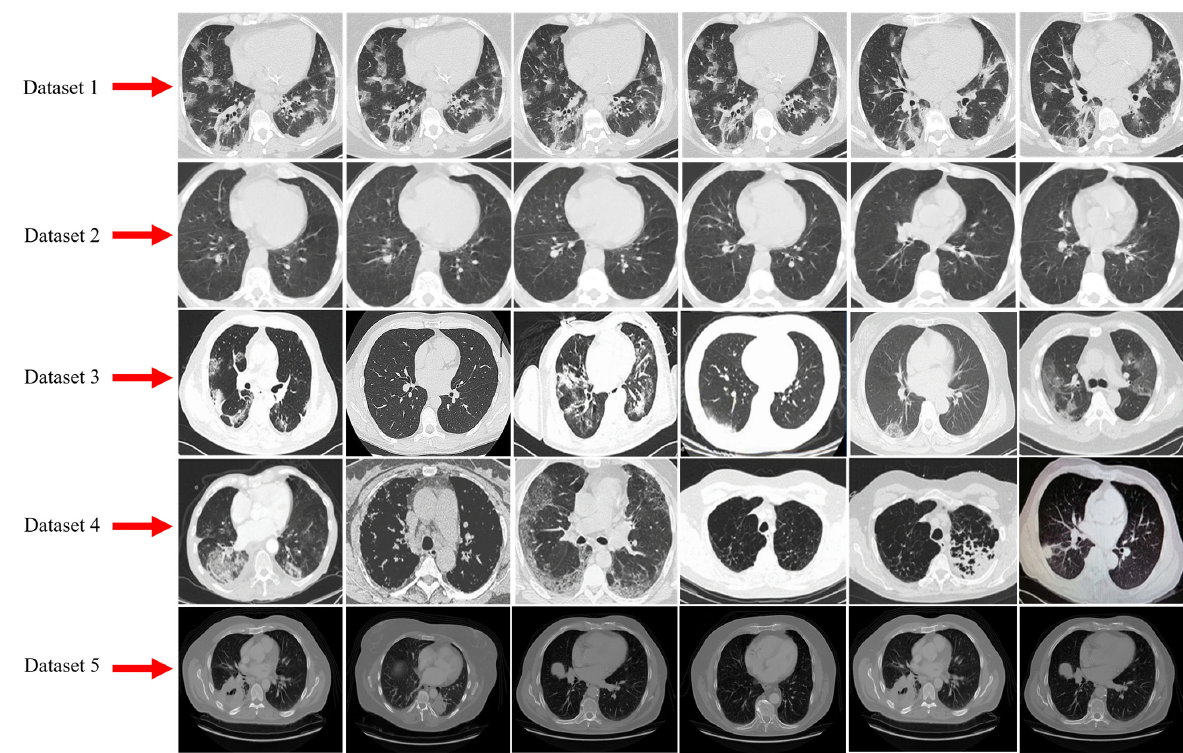
Figure 1 . Samples of CT scan images of COVID-19 were collected from Datasets 1 to 5. Figure 1. Samples of CT scan images of COVID-19 were collected from Datasets 1 to